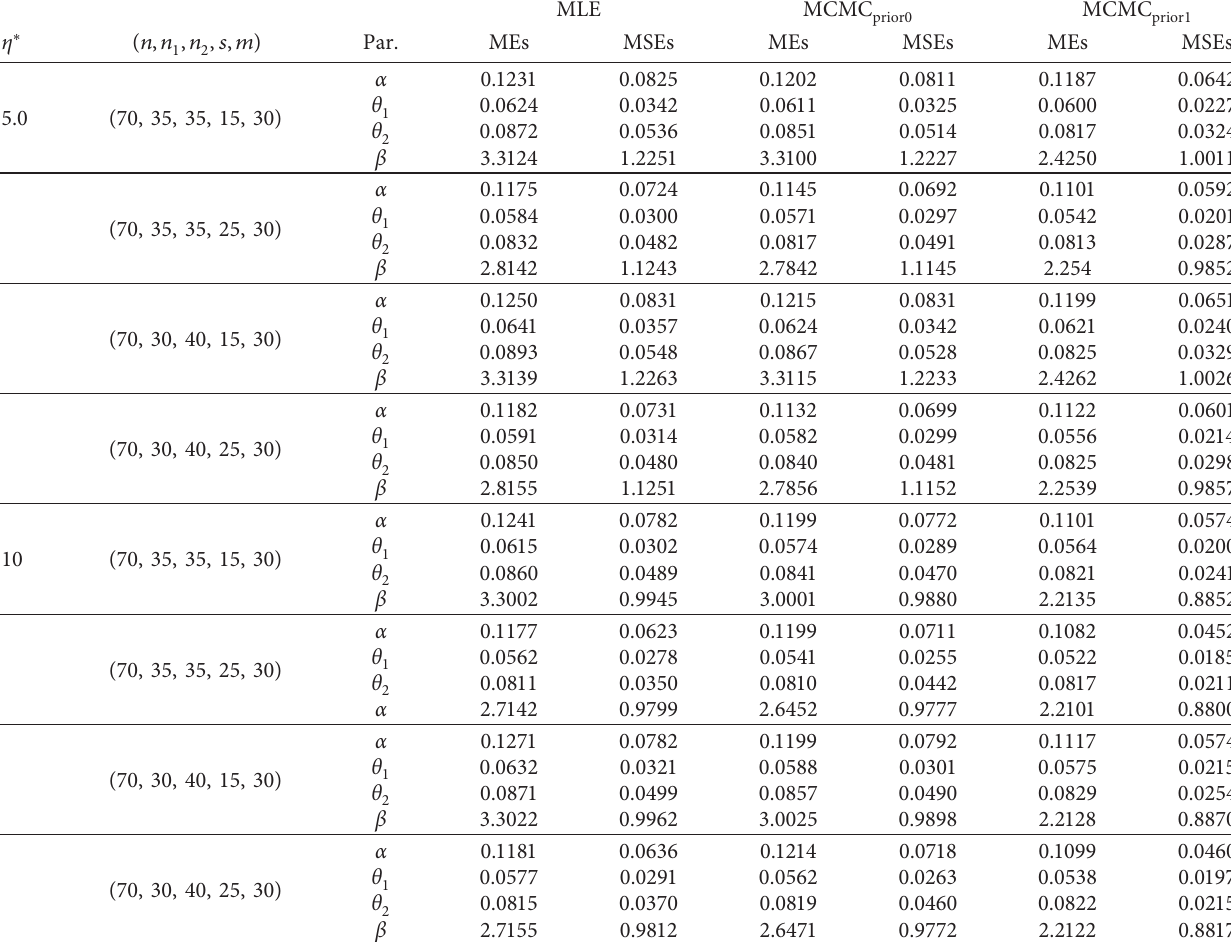
Table 1: MEs and MSEs for ( α , θ